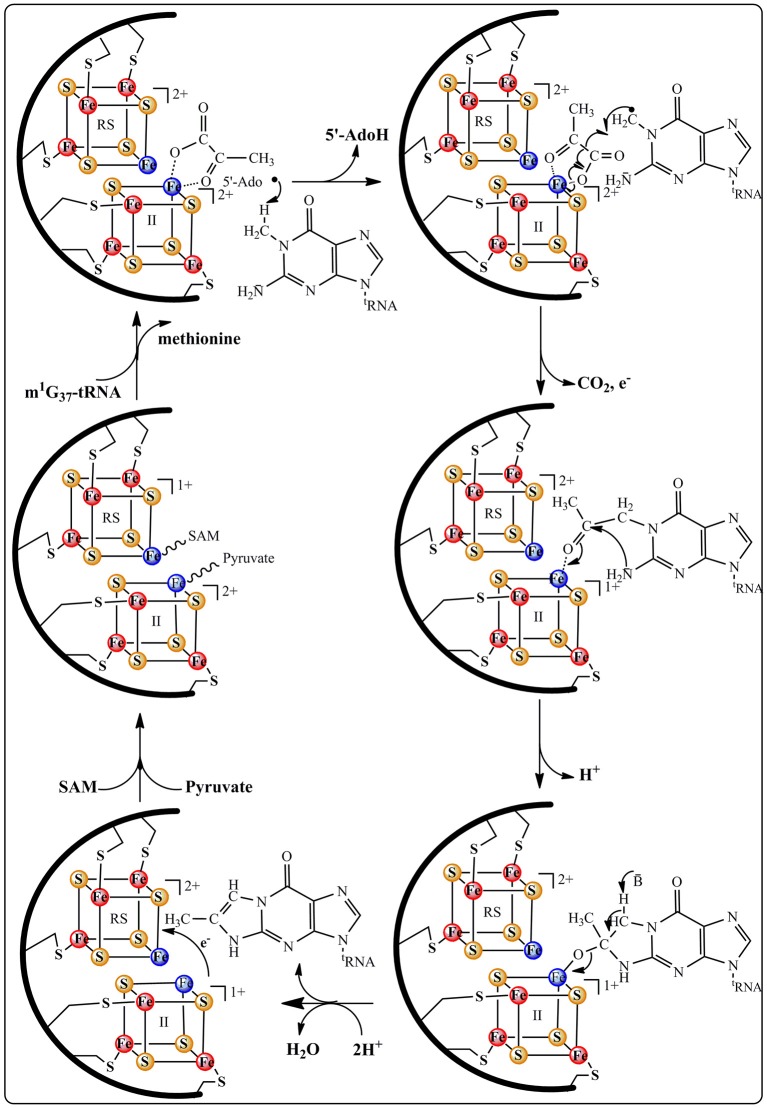
Proposed catalytic mechanism for ImG14 biosynthesis catalyzed by TYW1 enzyme.